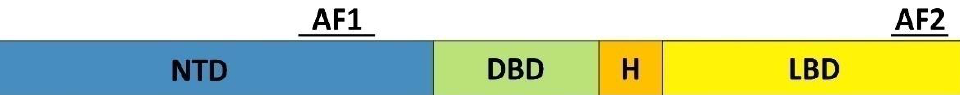
Figure 2. Schematic illustration of steroid receptor structure. NTD—amino-terminal domain, DBD—DNA-binding domain, H—hinge region, LBD—ligand-binding domain, AF1—activation function 1, AF2—activation function 2. The diagram does not show the exact length proportion of the domains because it differs between distinct SRs.